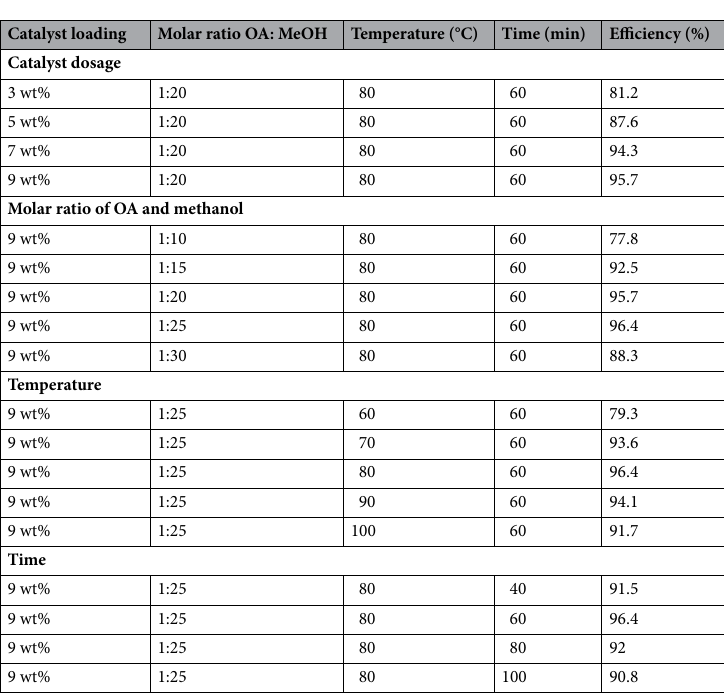
Table 2. Effect of various parameter on esterification reaction.